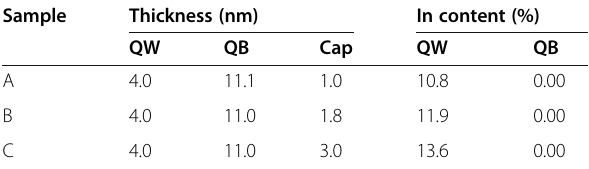
Table 1 Structural parameters of InGaN/GaN MQWs of samples A, B, and C determined by XRD measurements Sample